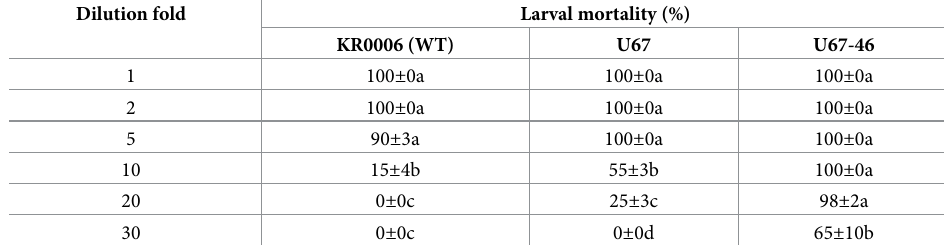
Table 2. Insecticidal activity of KR0006 (WT) and mutants (first and second) against Plutella xylostella . Dilution fold Larval mortality (%) KR0006 (WT) U67 U67-46 100 ± 0a 100 ± 0a 100 ± 0a 100 ± 0a 100 ± 0a 100 ± 0a 90 ± 3a 100 ± 0a 100 ± 0a 10 15 ± 4b 55 ± 3b 100 ± 0a 20 0 ± 0c 25 ± 3c 98 ± 2a 30 0 ± 0c 0 ± 0d 65 ± 10b Values are the mean of three replication and different letters in each column indicate significant differences in the Fisher’s LSD test (P <